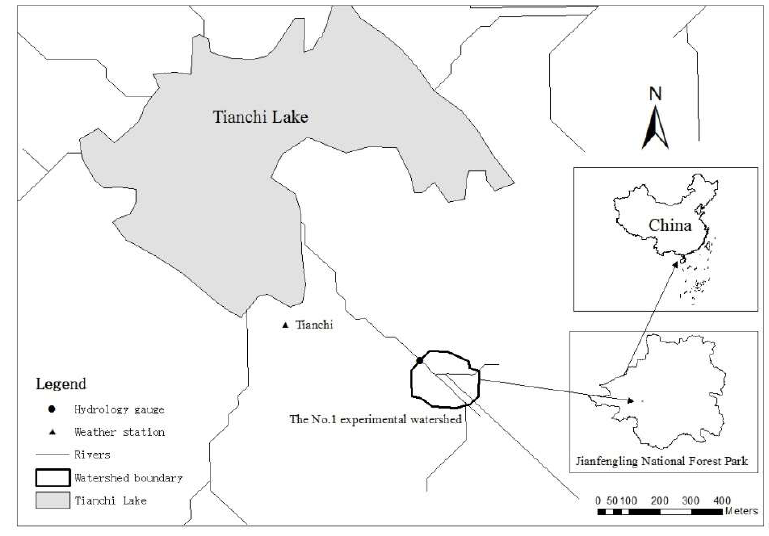
Figure 1. Location of the No.1 experimental watershed.